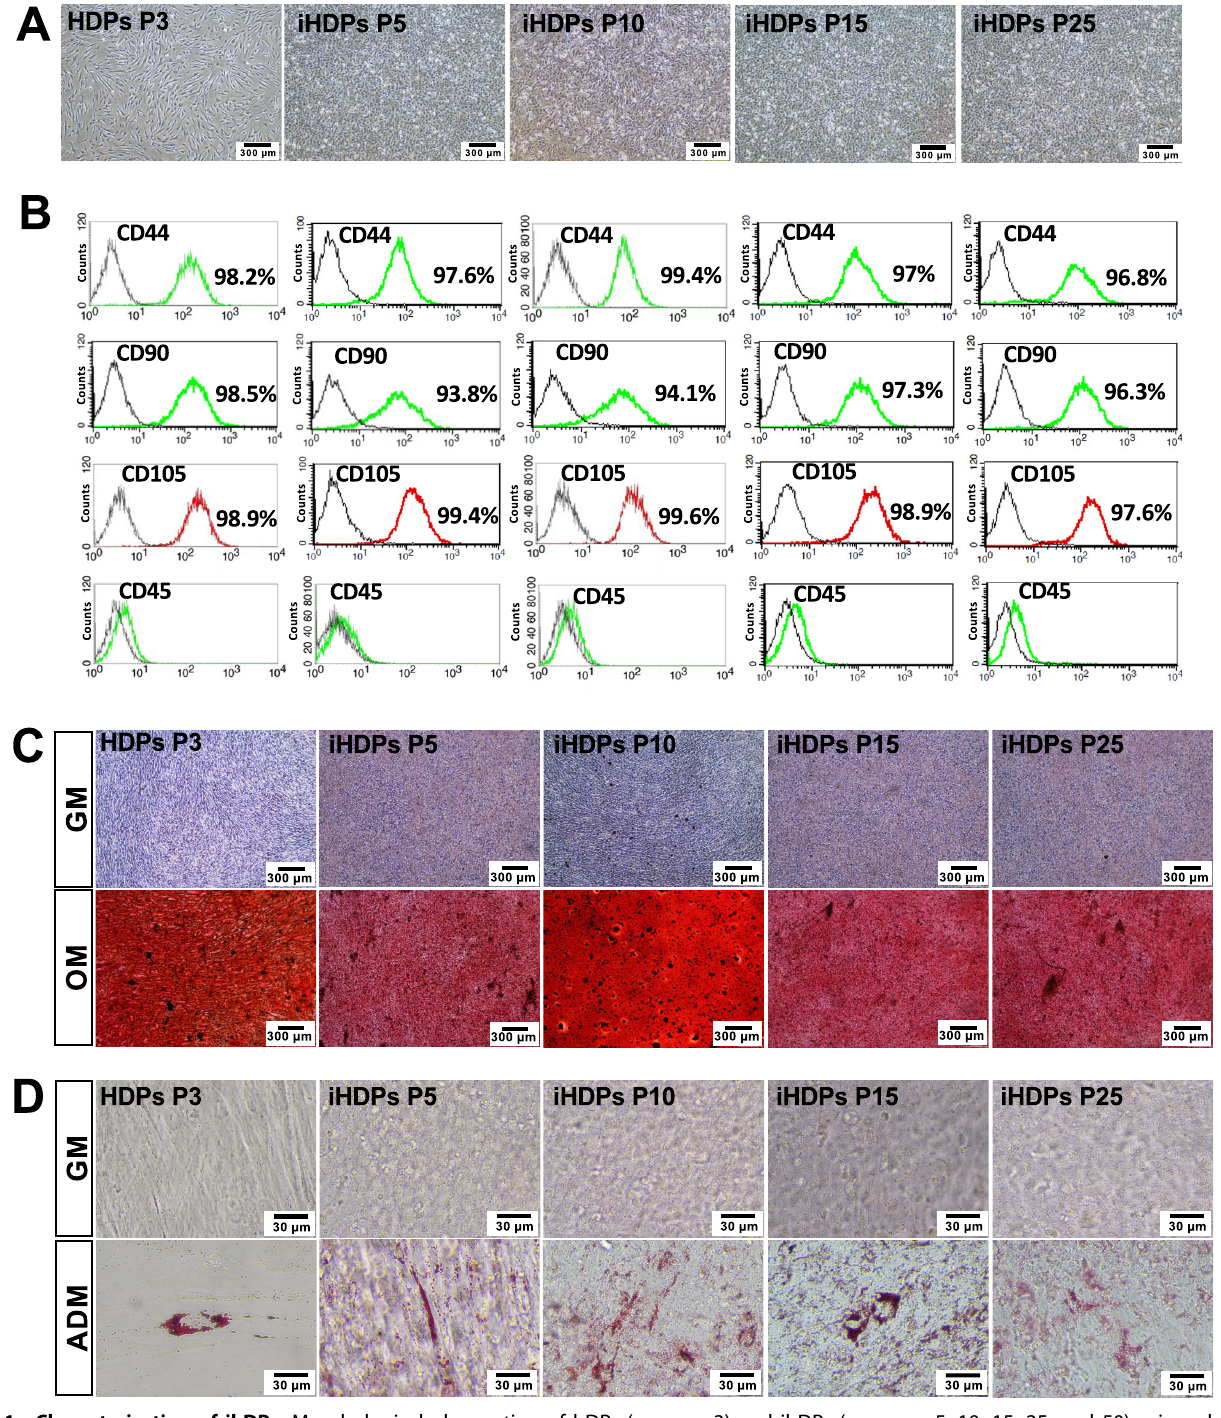
Fig. 1 Characterization of ihDPs. Morphological observation of hDPs (passage 3) and ihDPs (passages 5, 10, 15, 25, and 50) using phase- contrast microscopy. Scale bars: 300 µm ( A ). Evaluation of stem cell surface markers using fl ow cytometry ( B ). Multilineage differentiation potential toward osteogenic lineage. Scale bars: 300 µm ( C ). Oil red O staining after adipogenic induction. Scale bars: 30 µm ( D